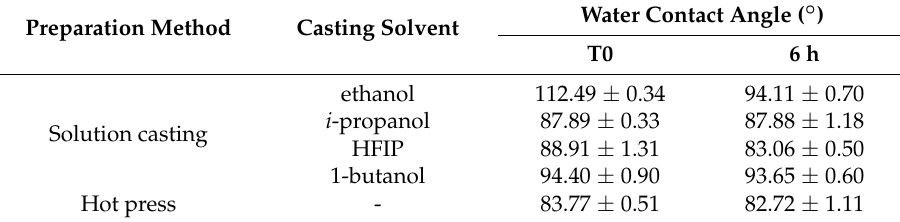
Table 3. Water contact angle measured on the ‘as prepared’ and photo-oxidated Pebax ® 2533 films.